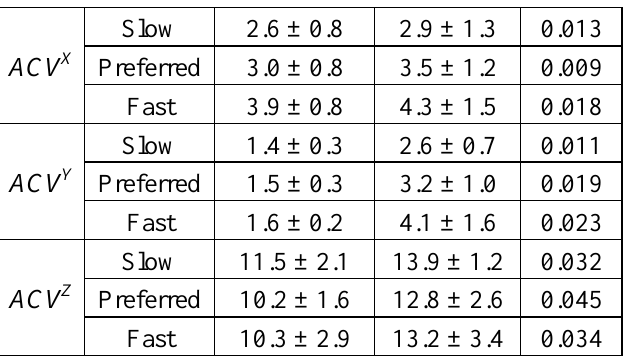
Light green bar: Without obstacles Dark gray bar: With obstacles